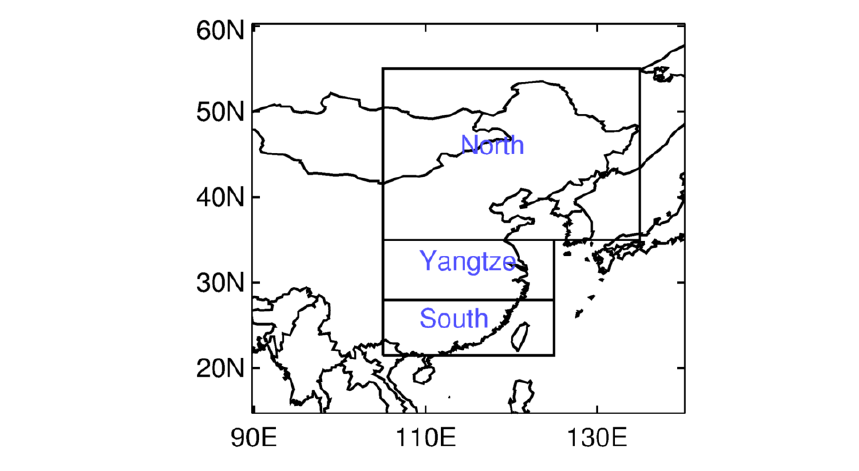
Figure 8. Domains used for regional water budget